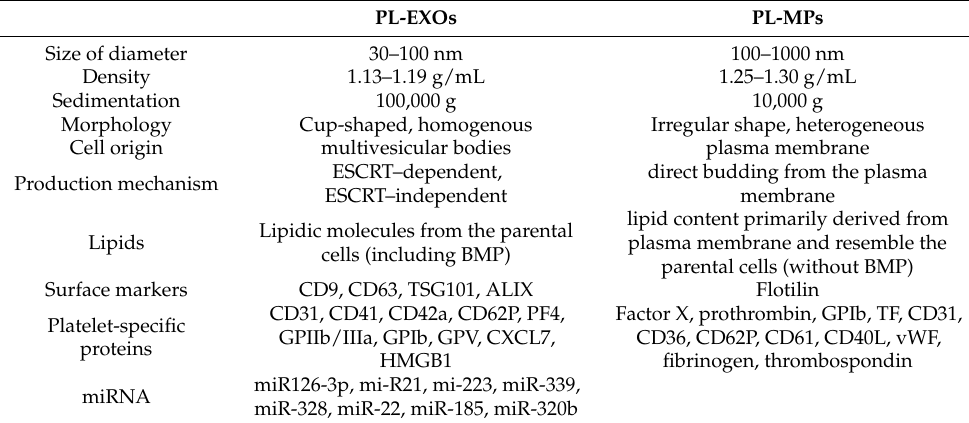
Table 1. Characteristics of main platelet-derived extracellular